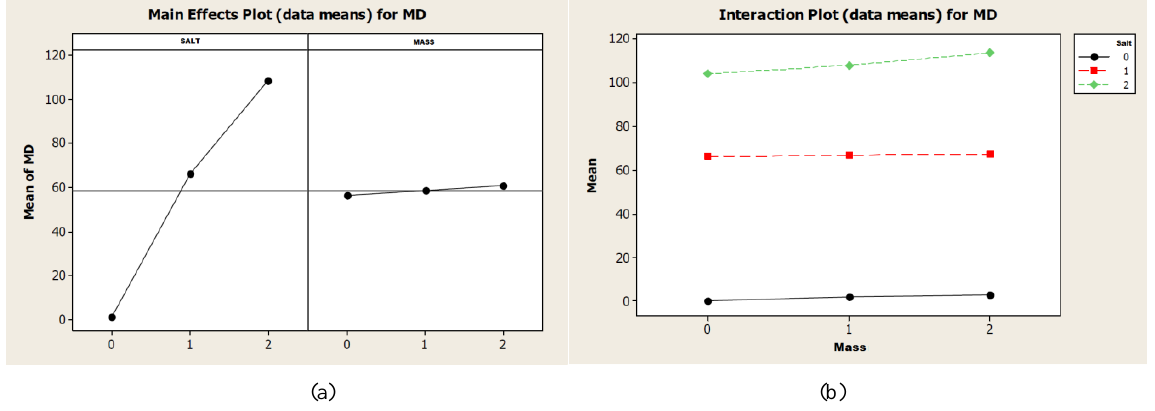
Fig. 10. Main effects of the ionic environment: (a) Isolated effects; (b) Cross effects.